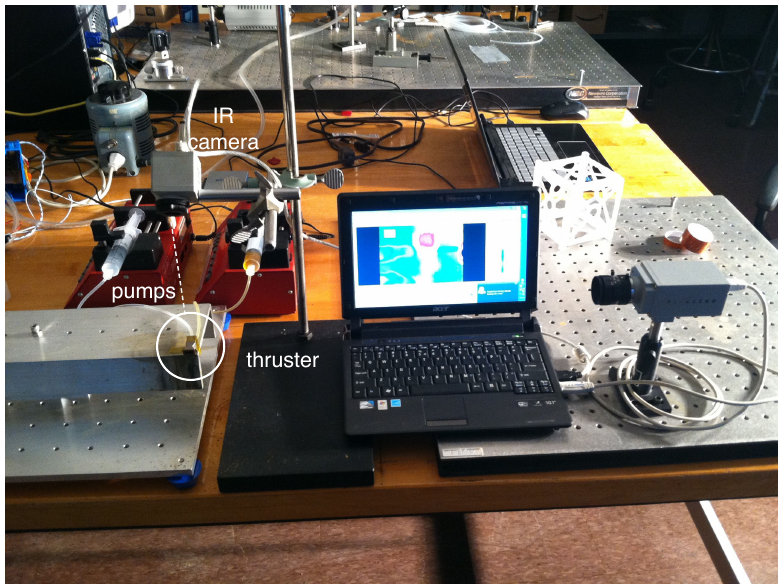
Figure 11. Photograph of thermal imaging set-up including thermal imaging camera, PixeLink camera, syringe pumps, and DMLS